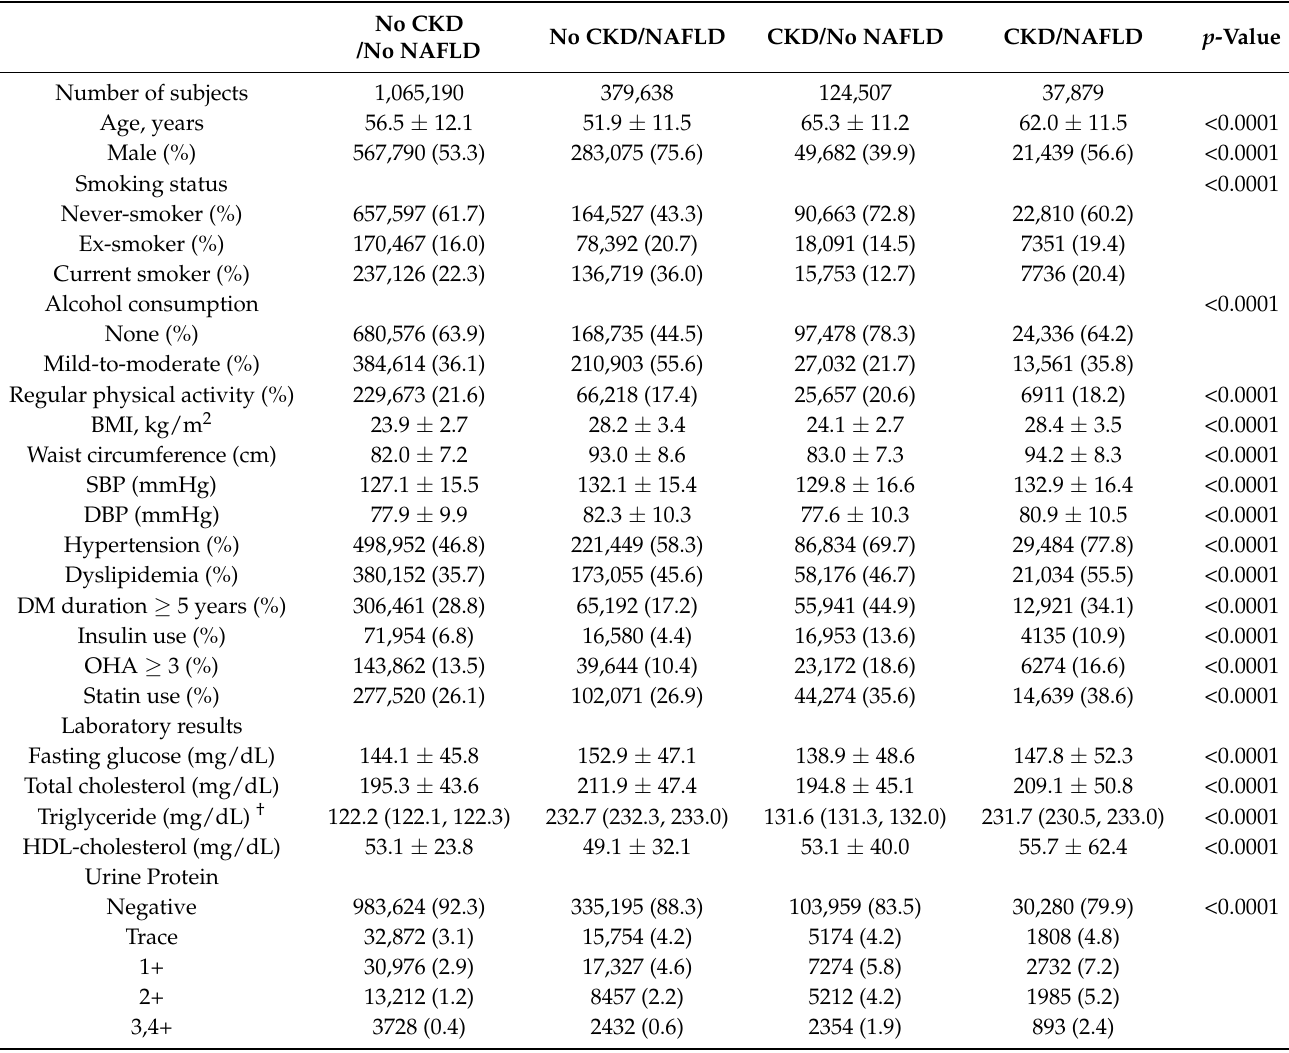
Table 1. Baseline characteristics of the study